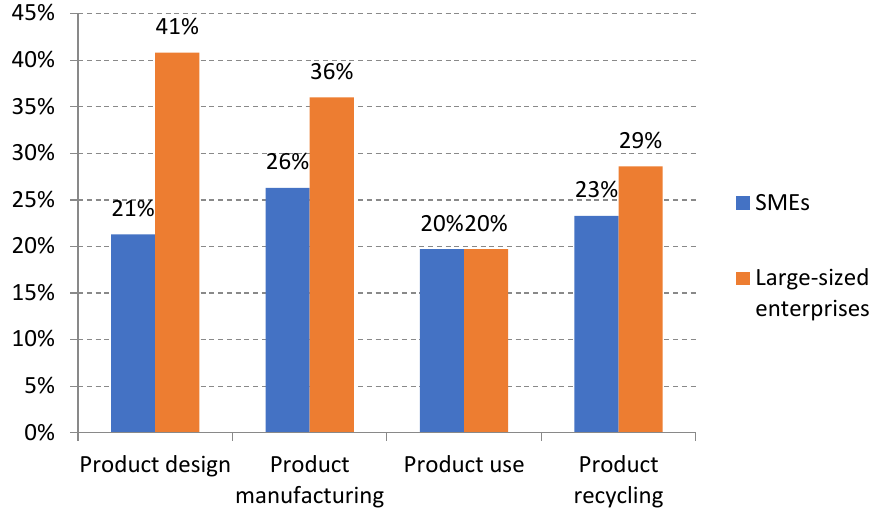
Figure 2. Implementation of environmental solutions in enterprises.